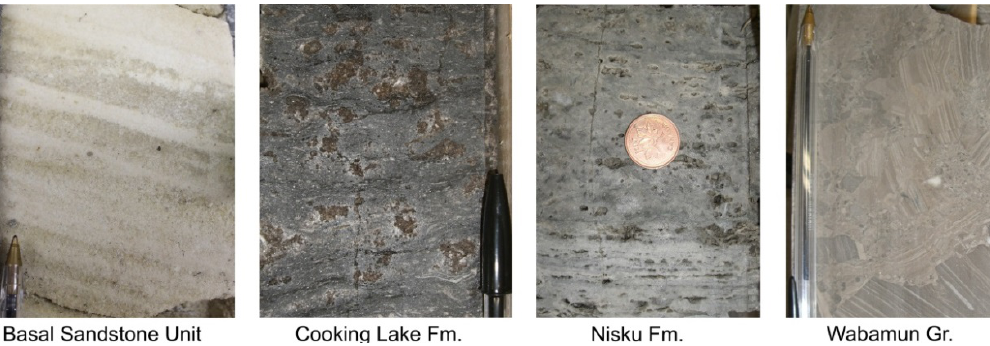
Figure 2. Core samples from potential geothermal target formations.